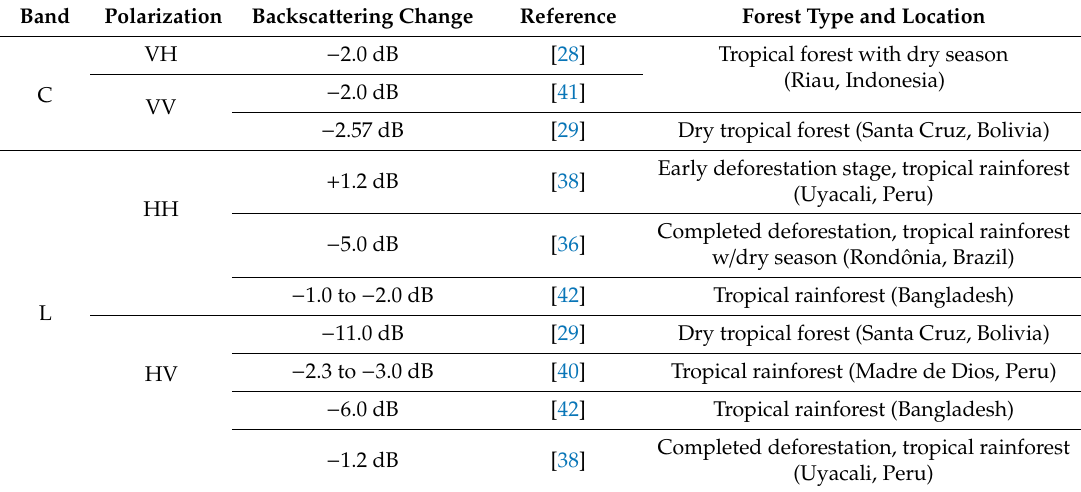
Table 2. Selected references for backscattering change after tropical forest clear-cut. Band Polarization Backscattering